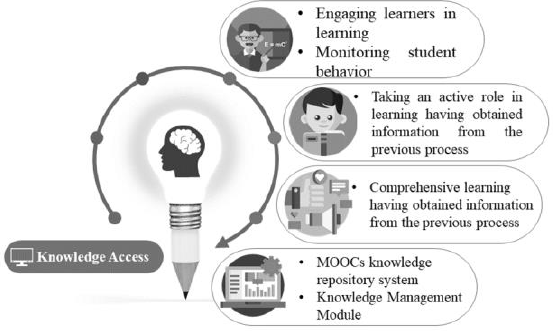
Fig. 7. Knowledge Access